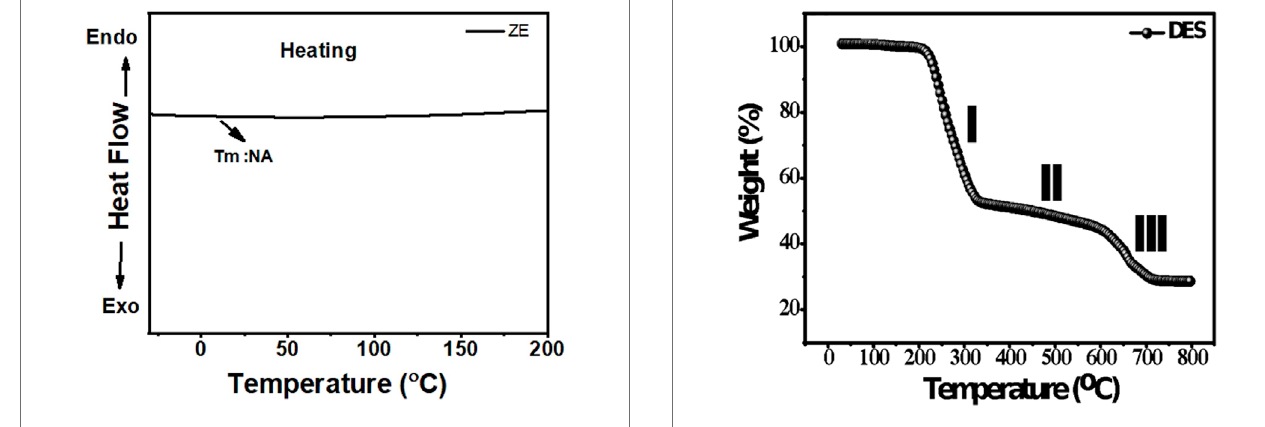
FIGURE3 | DSC traces ofthe ZE DES electrolyte at − 30to200 ° Cwith a heating rate of 5 ° C min − 1 .